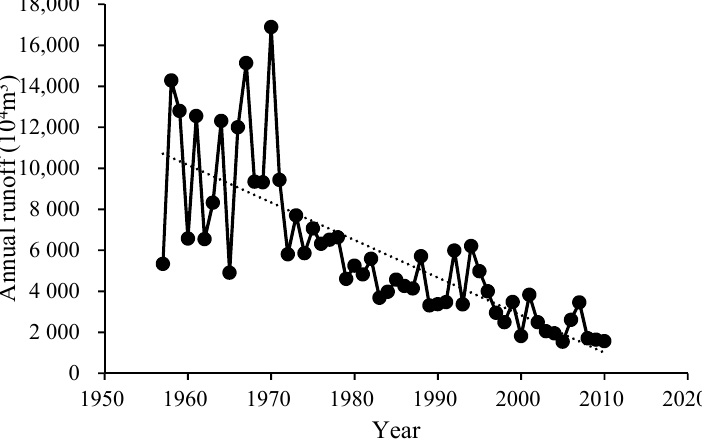
Figure 3. The annual runoff series of the JRB from 1959 to 2010.